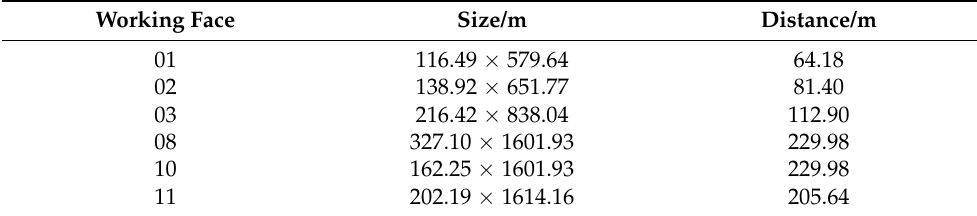
Table 3. Statistics of size of the working face and the distance from the adjacent roadway. Working